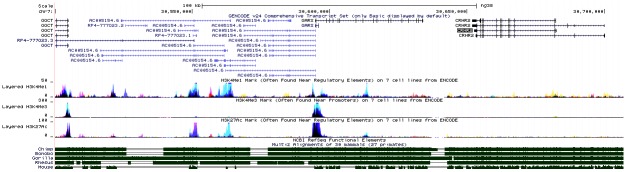
Multiple sequence alignment and histone marks of the genomic region of AC005154.6 (USCS genome browser GRCh38/hg38; http://genome.ucsc.edu/).